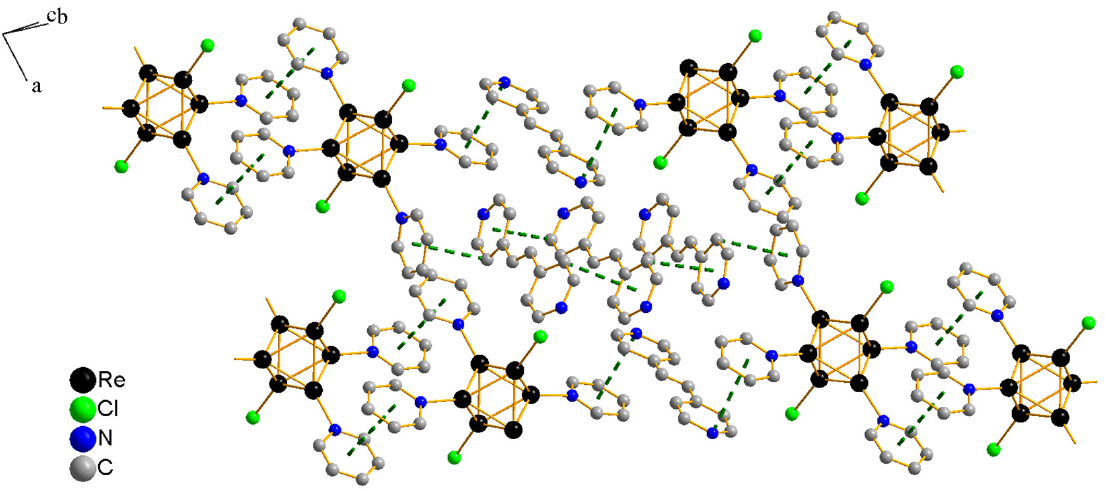
Figure 3. Packing fragment of cluster fragments in the structure of compound 1 · solv . Solvate bpe molecules and parts of the ligands not involved in binding interactions, as well as µ 3 -S ligands, are not shown.